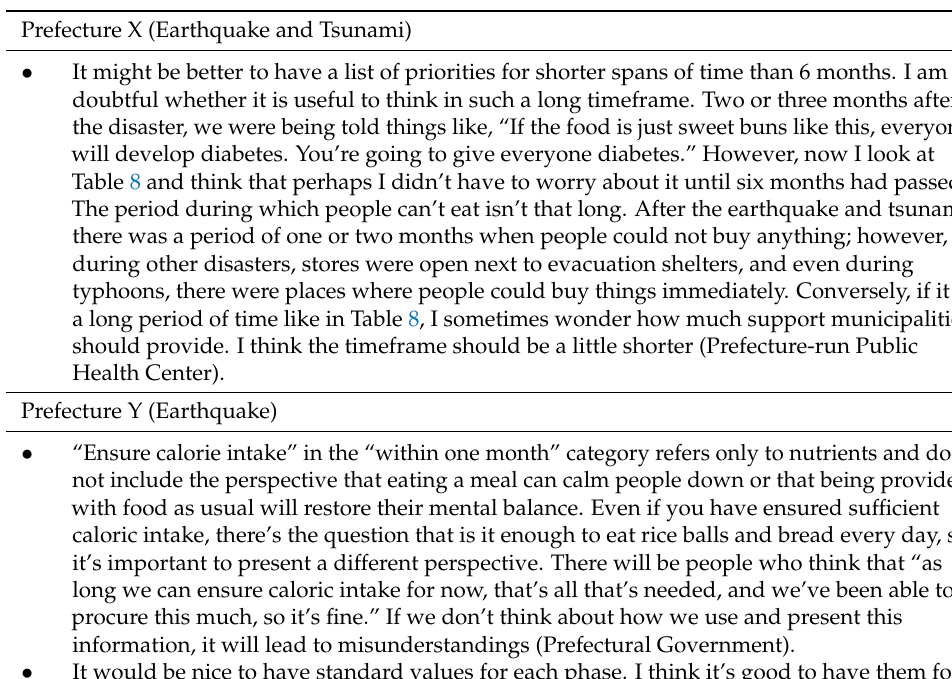
Table 9. Should the priority of nutrients be indicated for each phase?